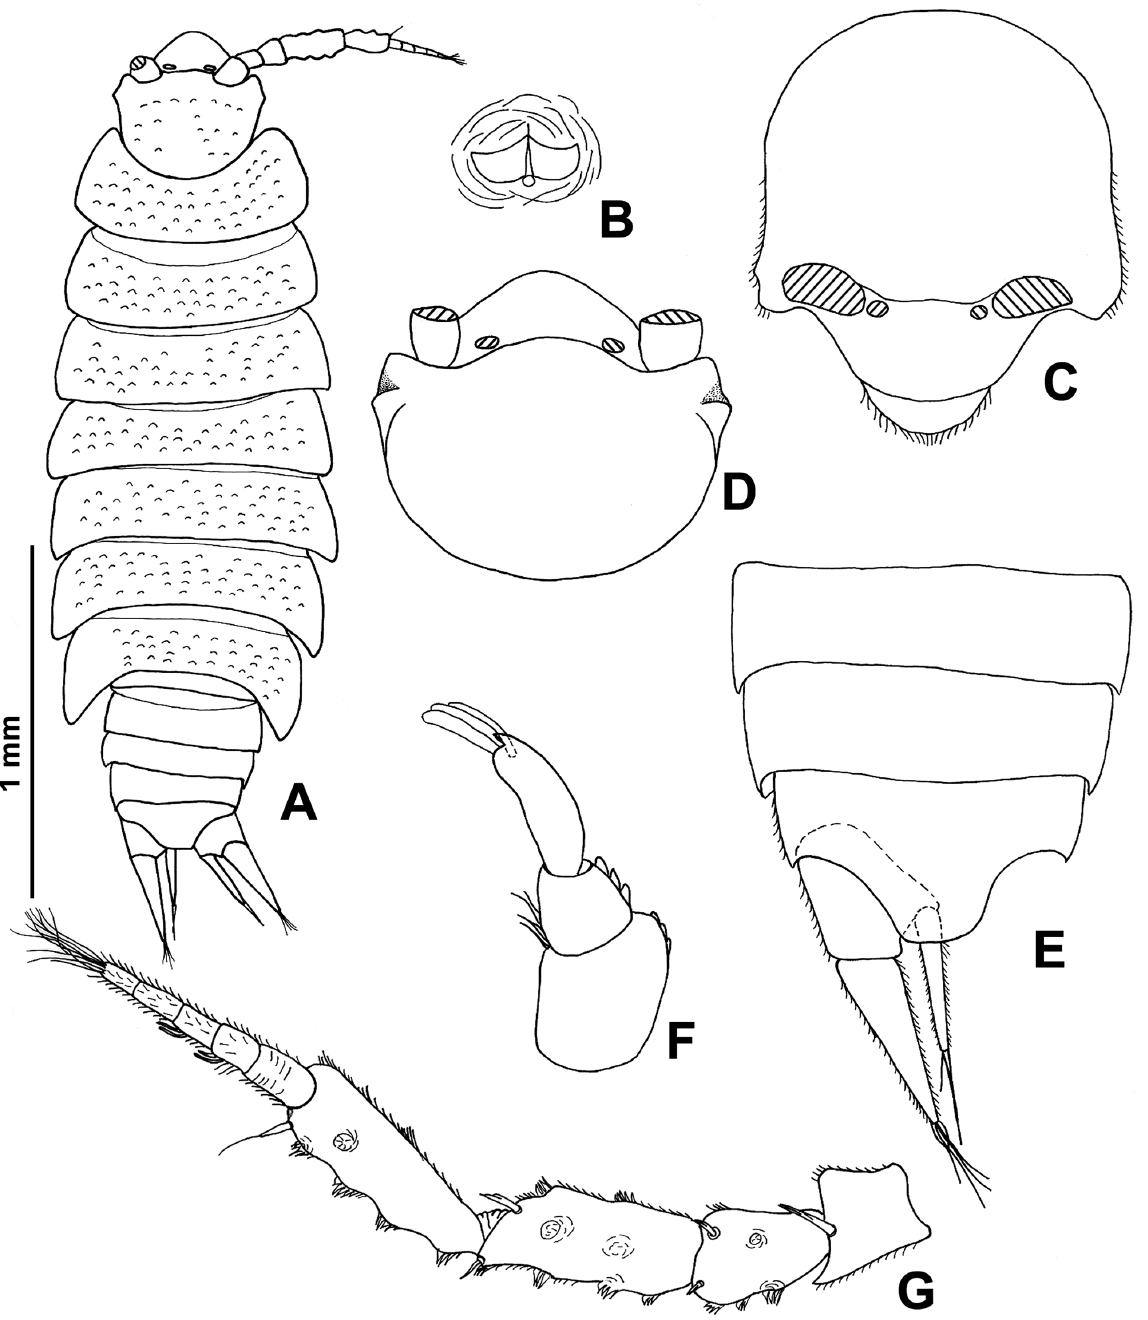
Fig. 13. Troglonethes olissipoensis Reboleira & Taiti sp. nov. from Gruta de Alvide, Lisbon Peninsula. — Paratype, ♀. A . Adult specimen in dorsal view. — Paratype, ♂. B . Dorsal scale-seta. C . Cephalon in frontal view. D . Cephalon in dorsal view. E . Pleonites 4, 5, telson and left uropod. F . Antennula. G .